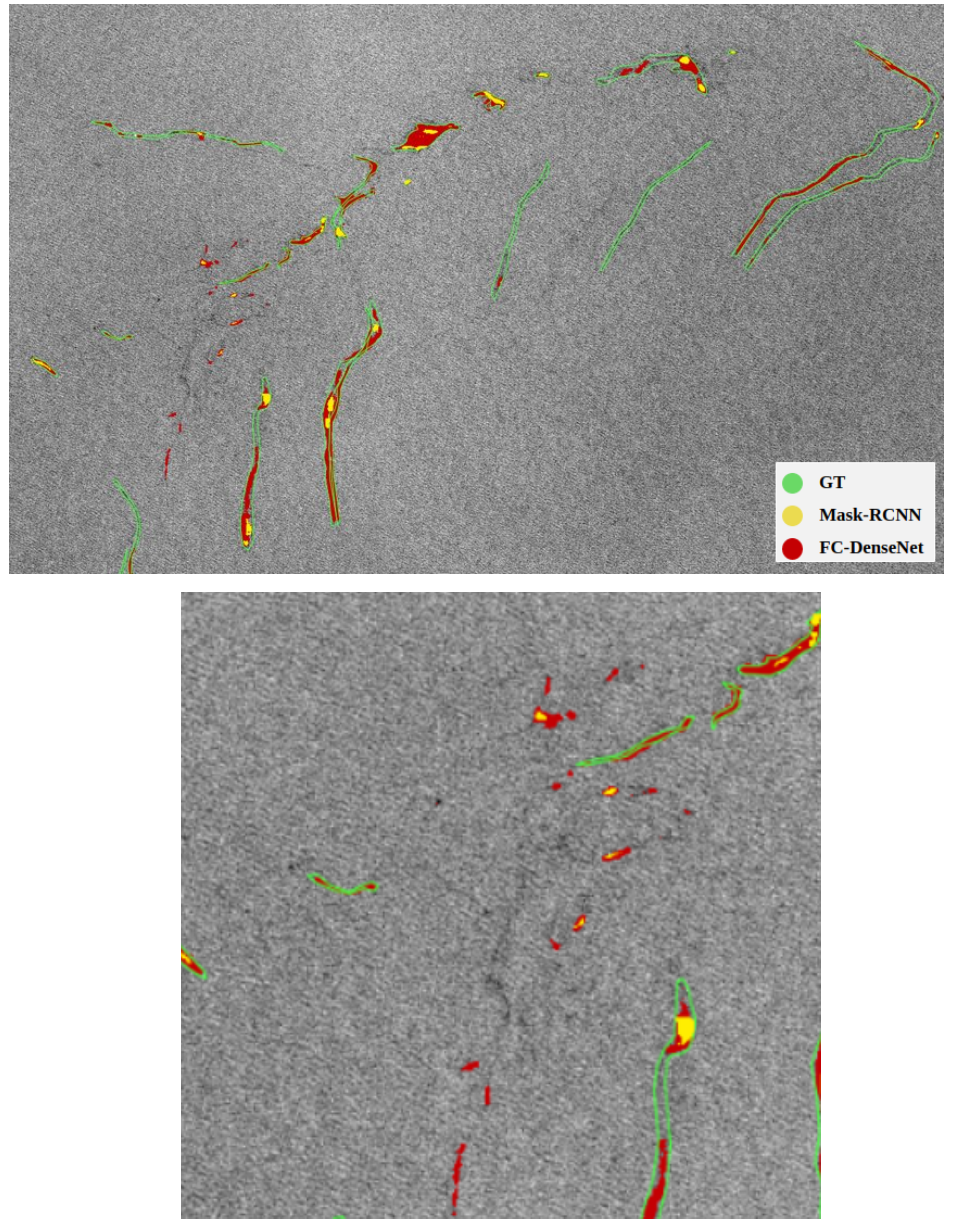
Figure 12. An example of FC-DenseNet (red) and Mask R-CNN (yellow) prediction on Sentinel-1 images where green polygons represent manual slick annotations. A zoom in on an area of interest is placed at the bottom. Note that since Mask-RCNN is systematically within FC-DenseNet ones, Mask-RCNN masks are applied above FC-DenseNet to facilitate